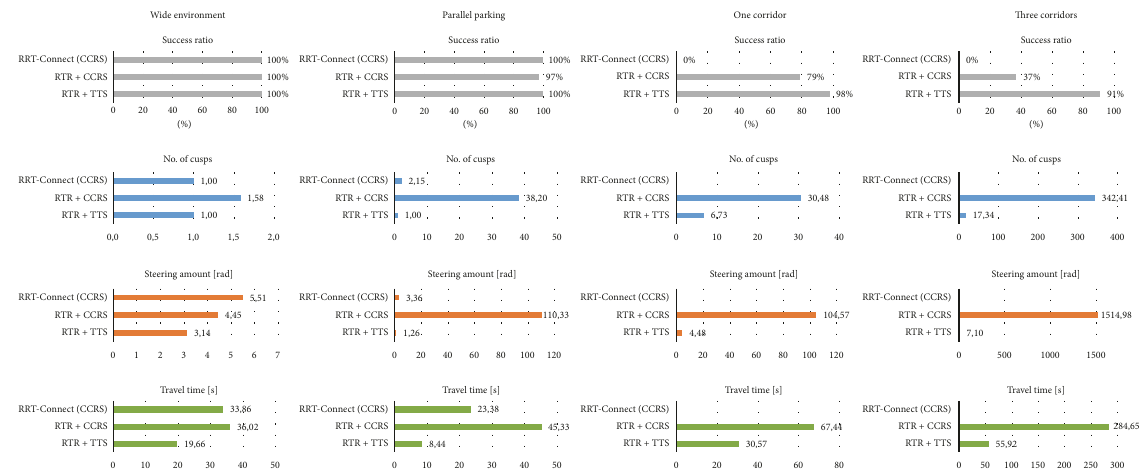
Figure 16: Summary of the simulation